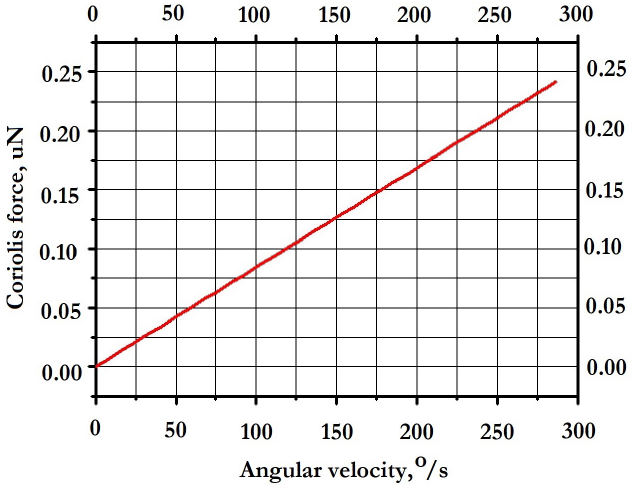
Figure 25. Graph of Coriolis force’s dependence on angular velocity.